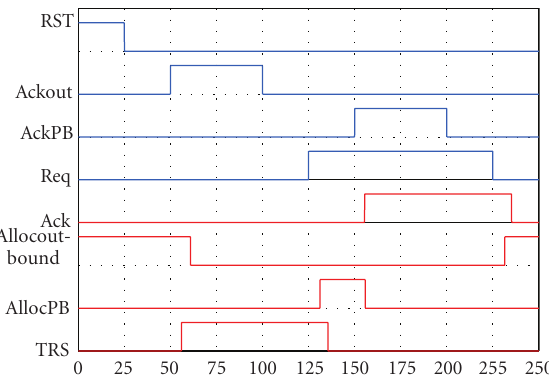
Figure 16: Simulation of the EHF version of the mp-for-pkt.